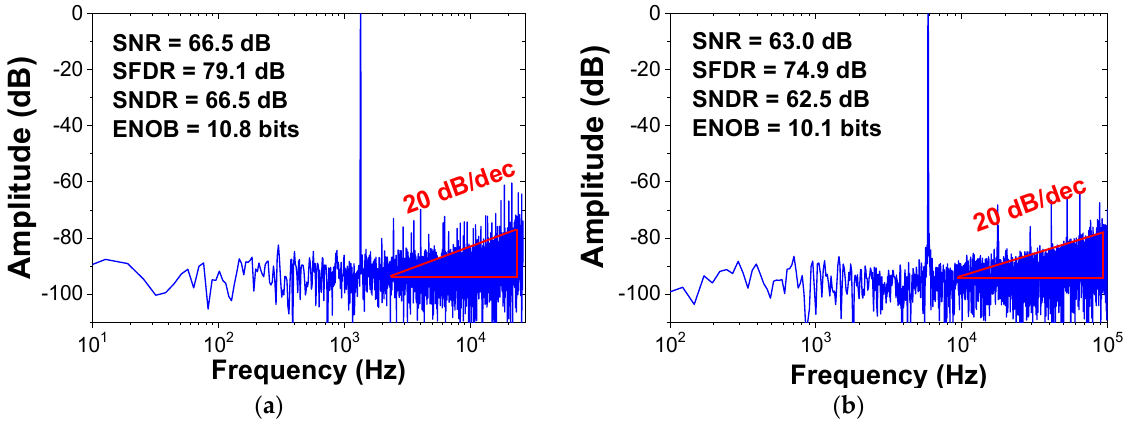
Figure 13. Measured output spectrum of the ADC. ( a ) f in = 1.33 kHz and f S = 52 kS/s and ( b ) f in = 8 kHz and f S = 180 kS/s.